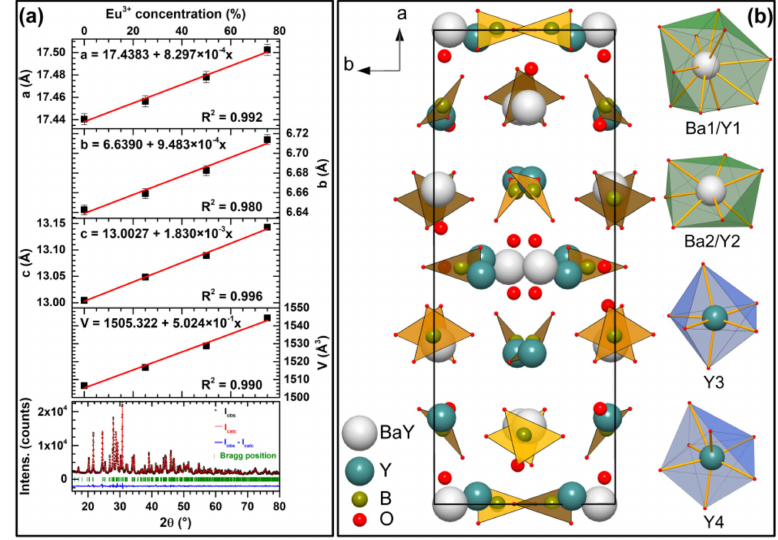
Figure 3. Unit cell parameters of Ba 2 Y 5 B 5 O 17 :Eu 3 + as a function of Eu 3 + concentration derived from the Le Bail fit and graphical representation of Ba 2 Y 5 B 5 O 17 Le Bail fit ( a ). Unit cell of Ba 2 Y 5 B 5 O 17 along the c-axis and coordination polyhedrons that Eu 3 + ions could possibly occupy ( b